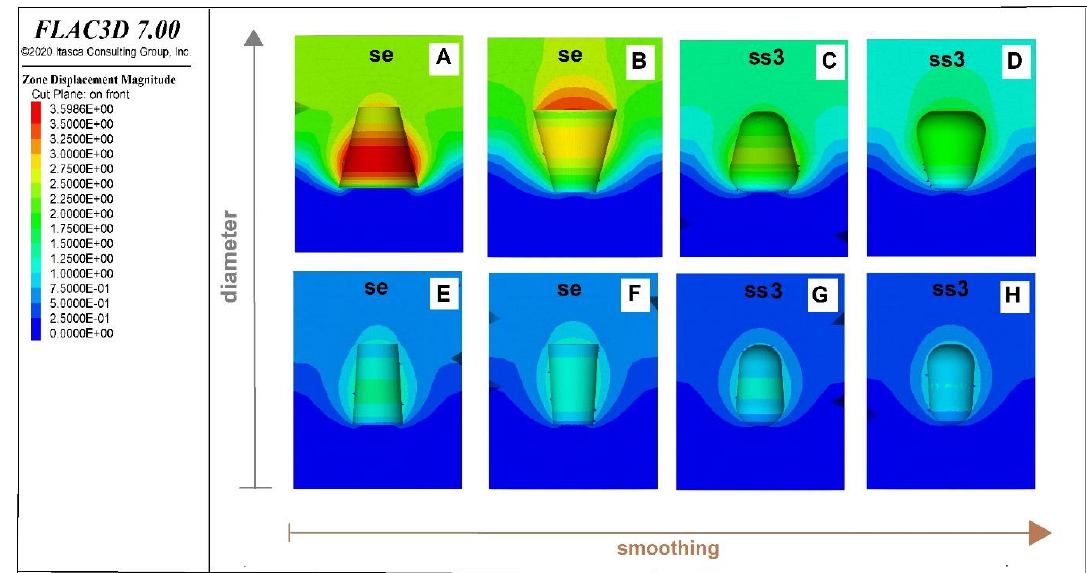
Figure 8. The displacement value and distribution in simulated caverns; the last injection period: ( A – D ) maximum initial diameter of 120 m, ( E – H ) maximum initial diameter of 75 m.